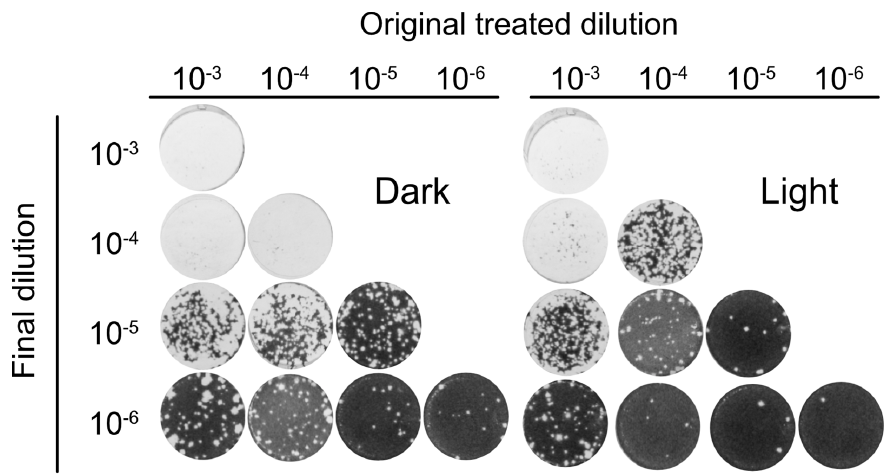
Figure 5. Orthoquin PDI inactivates HSV-1 across a 100-fold range of inoculum titer. Four dilutions of HSV-1 inocula (10 − 3 , 10 − 4 , 10 − 5 , and 10 − 6 ) were mixed with 0.1 µg/mL Orthoquin and exposed to a 65 W LED light in clear (light) or black (dark) tubes for 10 min. Following treatment, each inoculum was diluted in multiple 10-fold dilutions to a final dilution of 10 − 6 and used to infect HeLa cell monolayers. Cells were fixed and stained as described in the methods. n = 3 independent biological replicates. Representative plaque assays are shown.